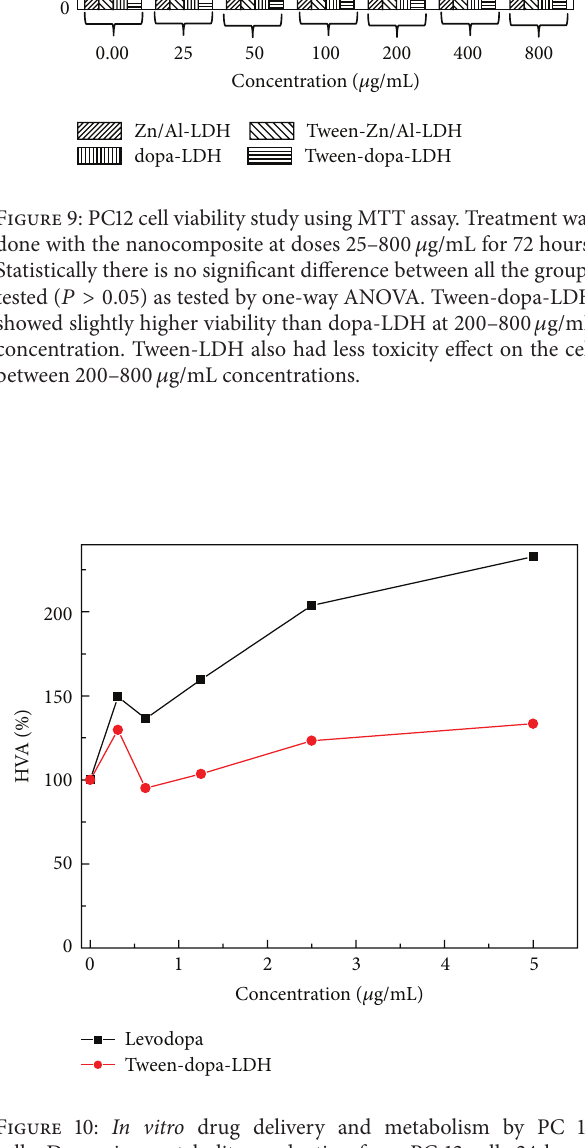
Figure 10: In vitro drug delivery and metabolism by PC 12 cells. Dopamine metabolite production from PC 12 cells 24 hours after treatment with increase concentration of levodopa and the corresponding Tween-dopa-LDH nanocomposite. HVA production increases with increase dopamine concentration from both naked levodopa and intercalated